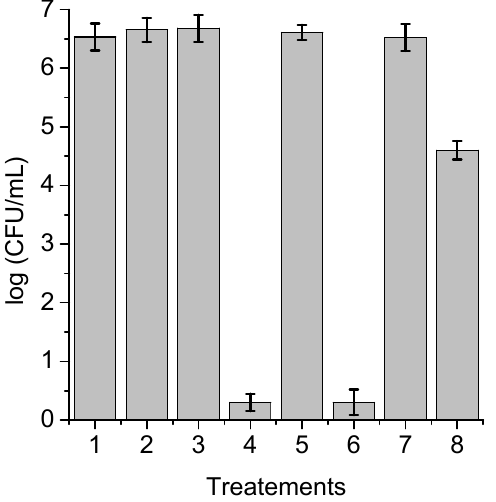
Figure 11. Survival of C. albicans incubated with 5 μ M PS for 18 h at 37 °C in the dark and irradiated with white light for 60 min; (1) cells in the dark; (2) irradiated cells; (3) cells treated with TPCF 16 in the dark; (4) irradiated cells treated with TPCF 16 ; (5) cells treated with ZnTPCF 16 in the dark; (6) irradiated cells treated with ZnTPCF 16 ; (7) cells treated with PdTPCF 16 in the dark; (8) irradiated cells treated with PdTPCF 16 .